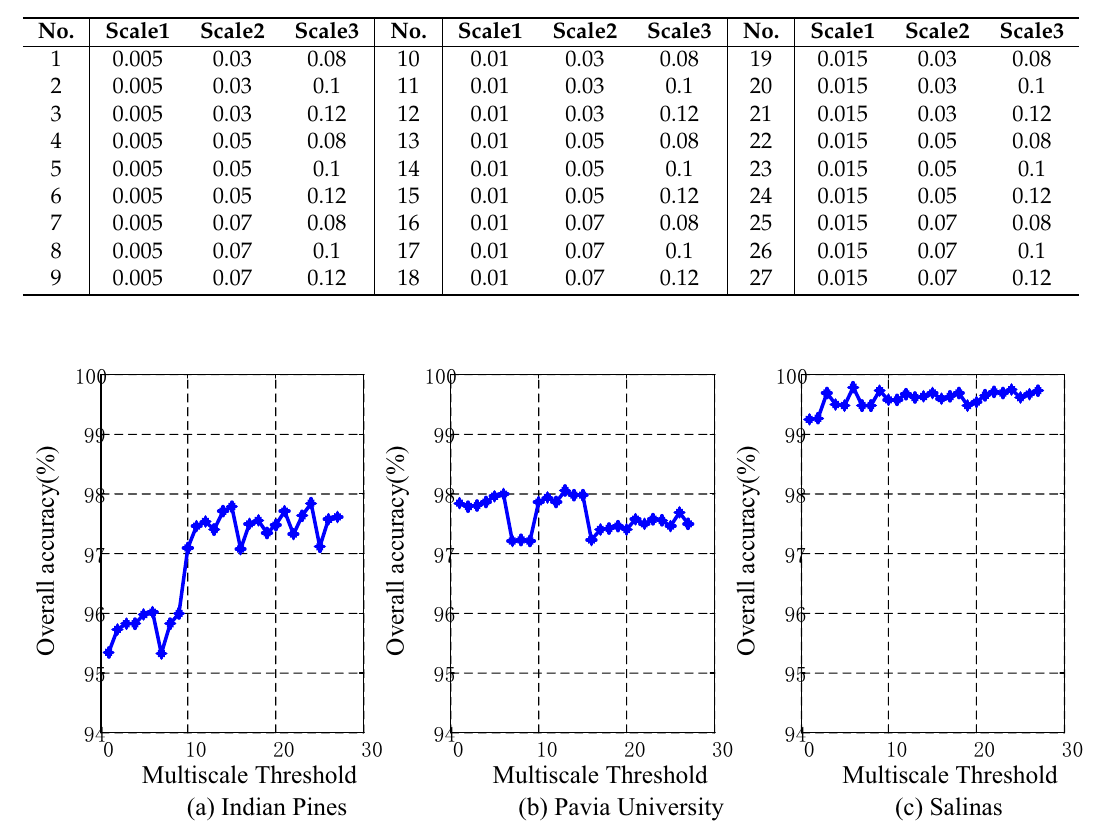
Table 5. Multiscale threshold values space.